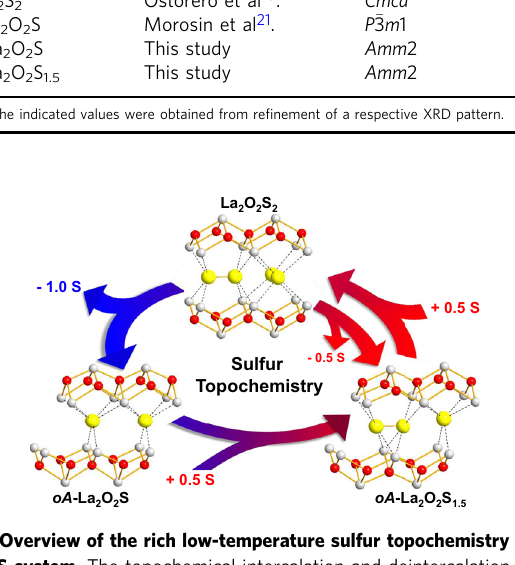
Table 1 Summary of crystallographic parameters of La 2 O 2 S x series (1 ≤ x ≤ 2.0). Compounds Source Space group